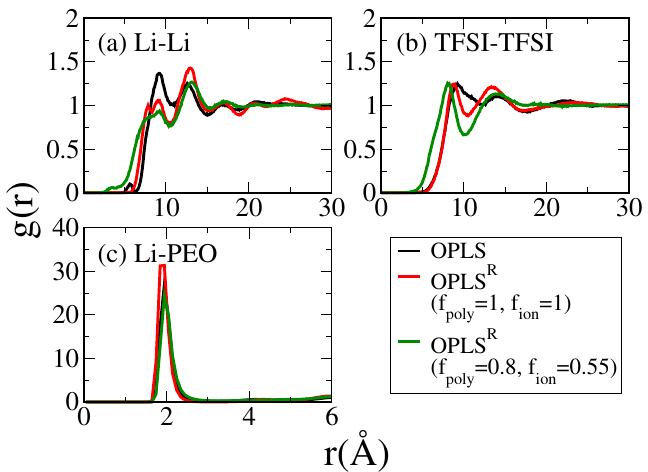
Figure 6. The radial distribution functions between pairs of ( a ) Li + -Li + , ( b ) TFSI − -TFSI − and ( c ) Li + -PEO oxygen for PEO/LiTFSI system at 333 K in different force fields.